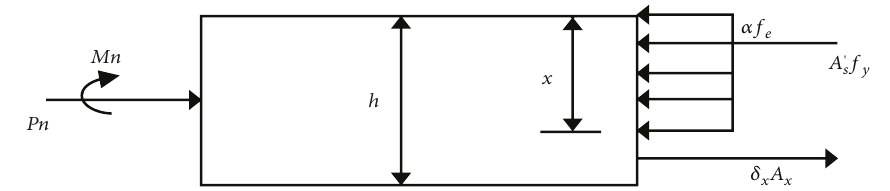
Figure 4: Calculation of the load-bearing capacity of column sections.